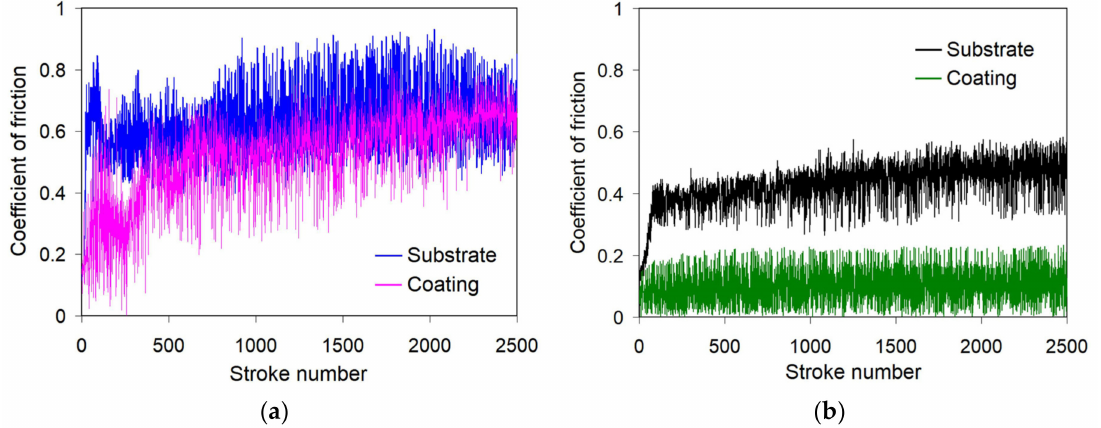
Figure 11. Variation of a mean CoF value during the wear test: ( a ) sliding against 100Cr6 ball, ( b ) sliding against SiC